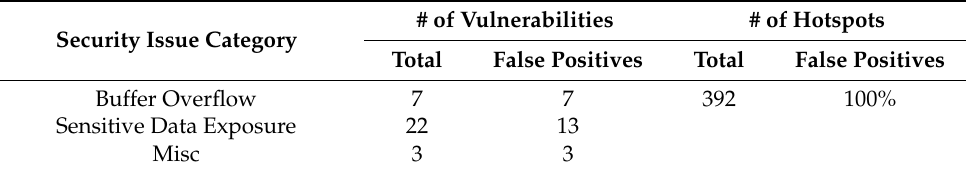
Table 10. Number of security issues of different categories in